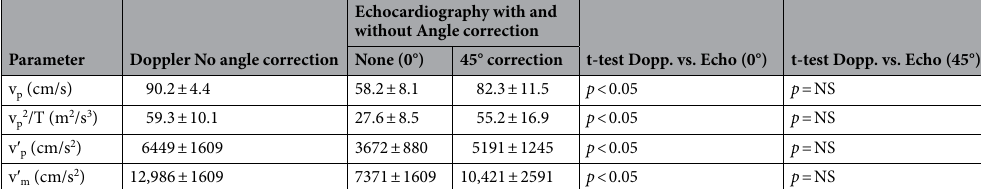
Table 2. Comparison of the four parameters derived from baseline aortic velocity signals measured simultaneously with DFVS and